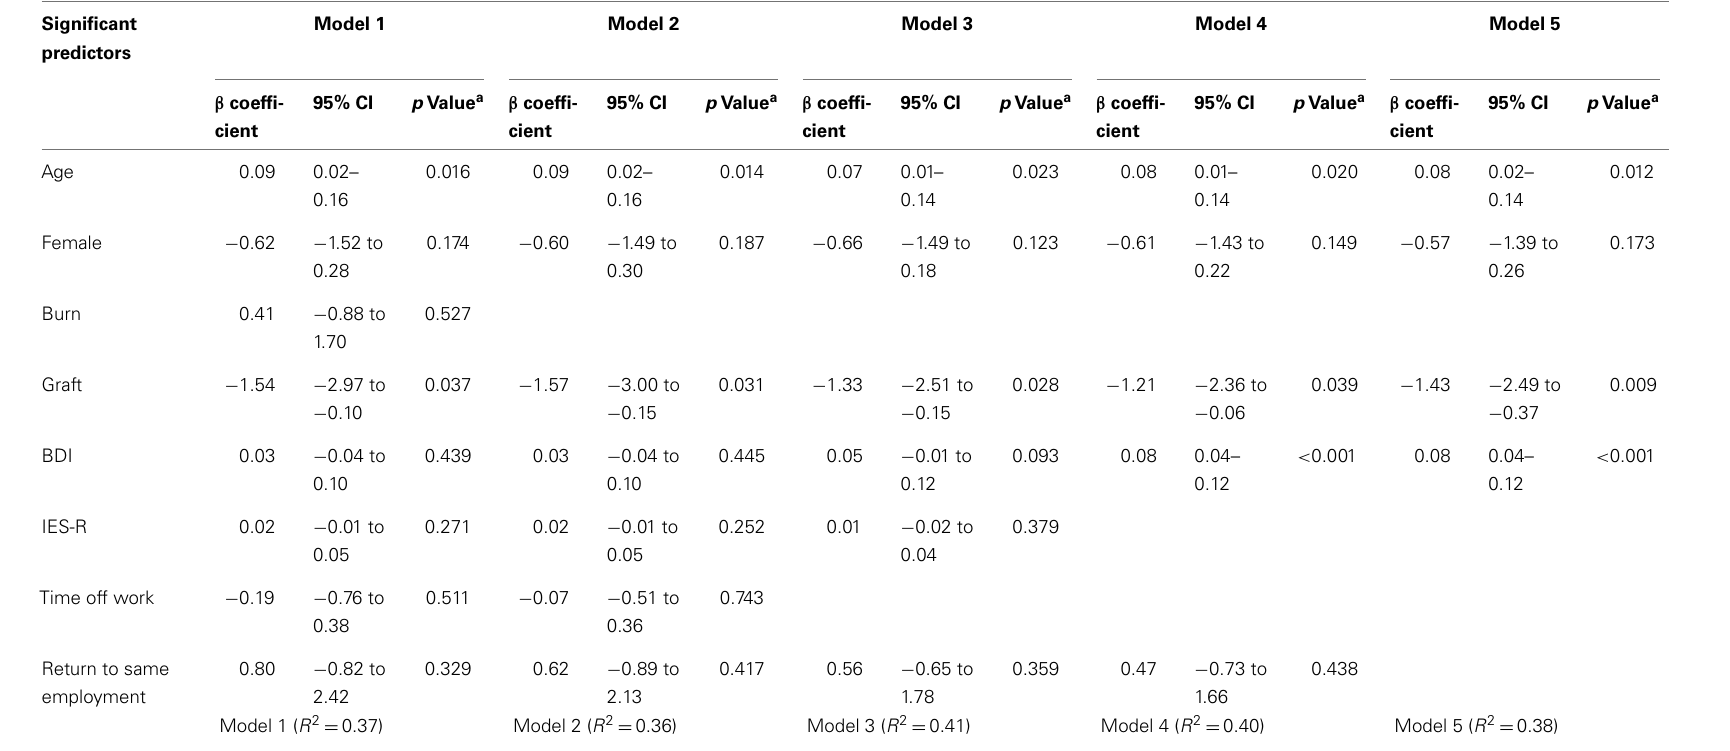
Table 4 | Stepwise multiple regression analysis examining predictors of pain